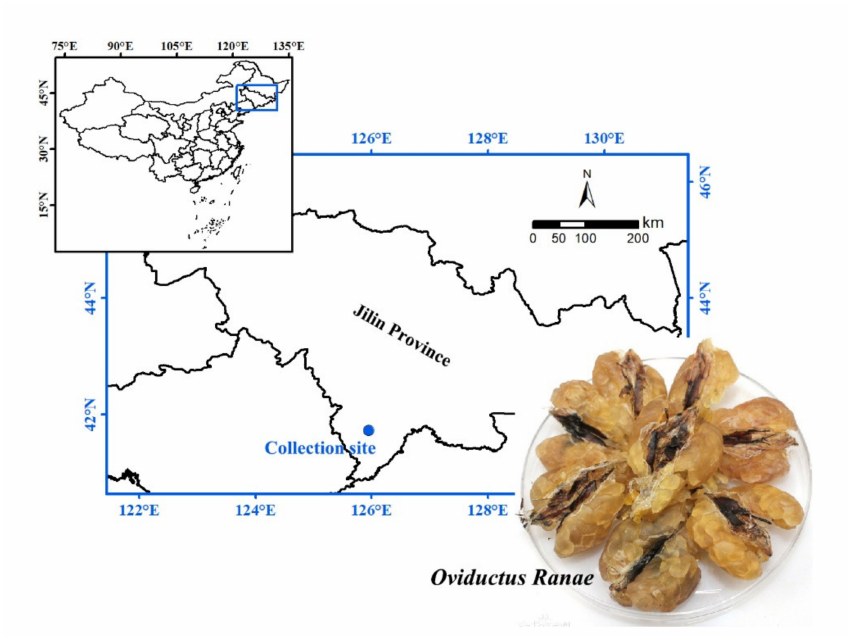
Figure 5. Oviductus Ranae sample and its collection site (the main producing areas of